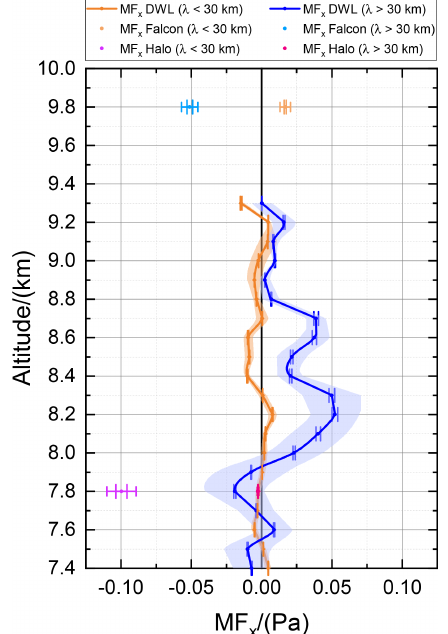
Figure 9. Leg-averaged MF profile calculated according to Eq. (3) for two different wave classes with λ < 30km in orange colors and λ > 30km in blue colors. The mean MF retrieved from the 2µmDWL data is denoted by the solid lines, the error bars denote the corresponding uncertainty which is approximated to be 4% of the mean value, and the shaded area indicates the uncertainty in- duced by the varying leg length. The in situ measurements are indi- cated by the dots in the respective